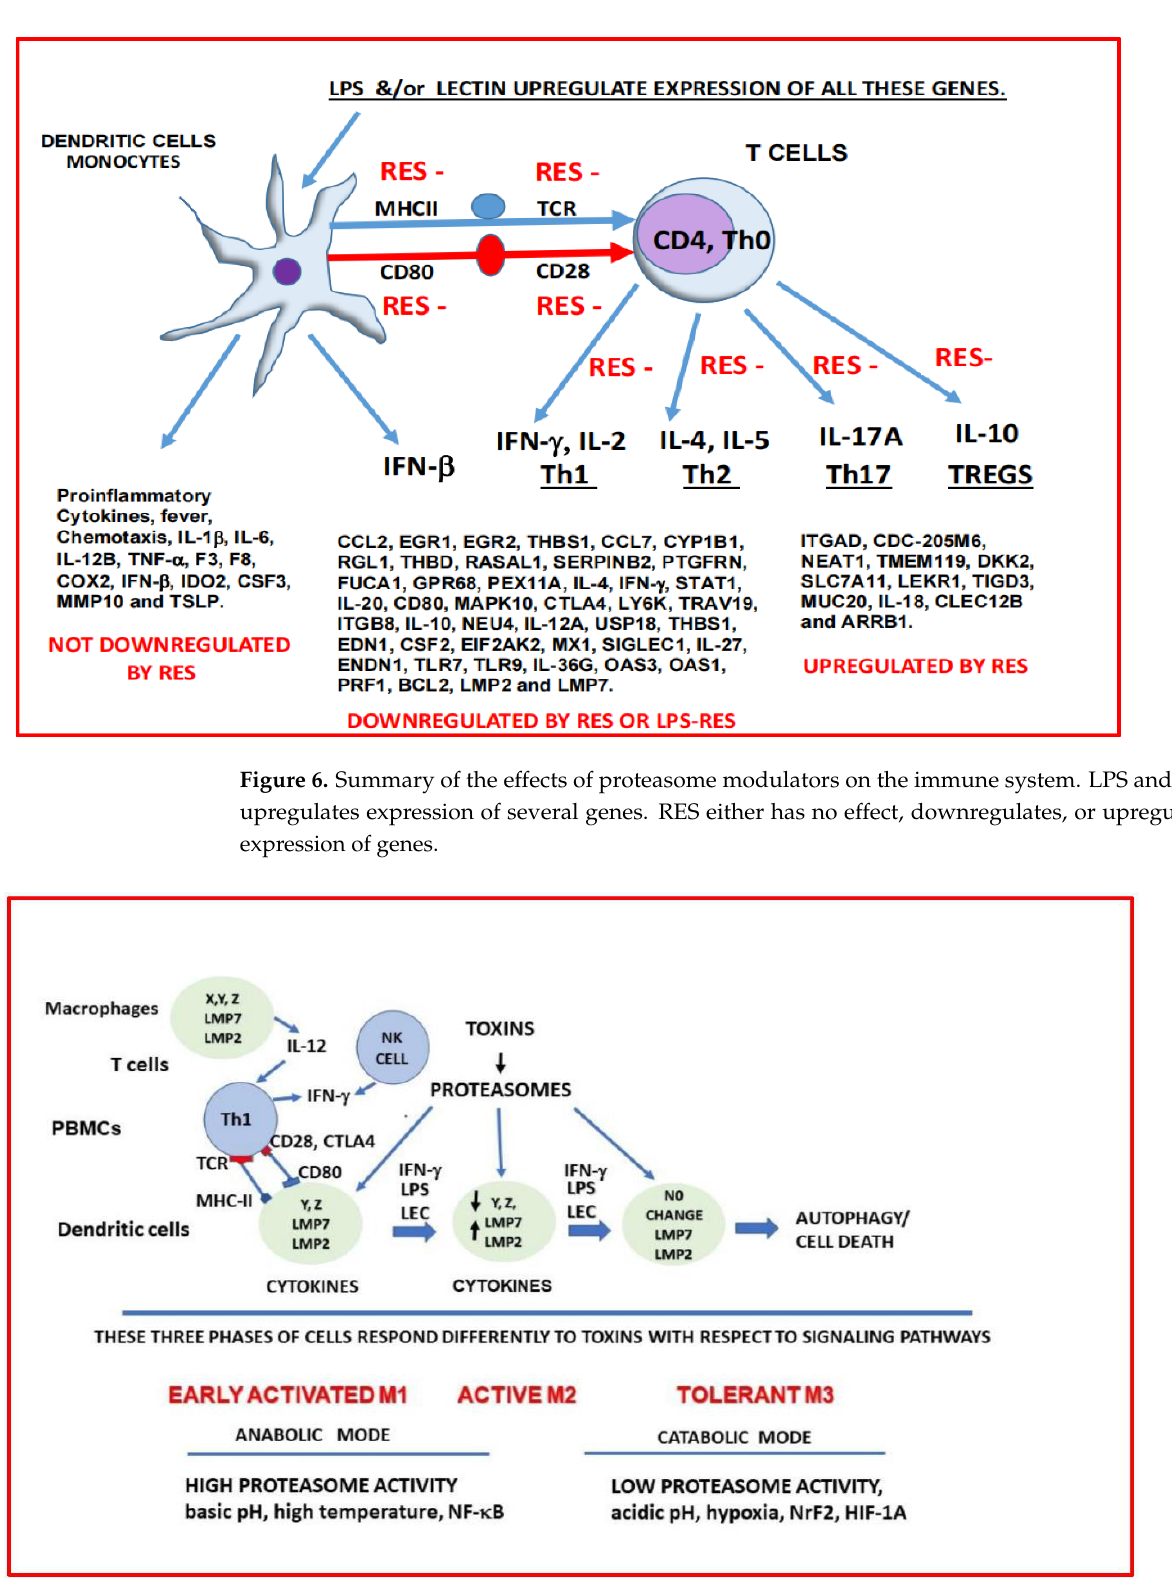
Figure 7. LPS, IFN- γ or LEC induces the reprogramming of the proteasomes with LMP7 and LMP2. The cell becomes tolerant and if the proteasome’s activities are completely inhibited then it may lead to autophagy. RES alone or in the presence can repress the induction of LMP7 and LMP2. RES can also inhibit the activity of the LMP7 protease more than the X protease.